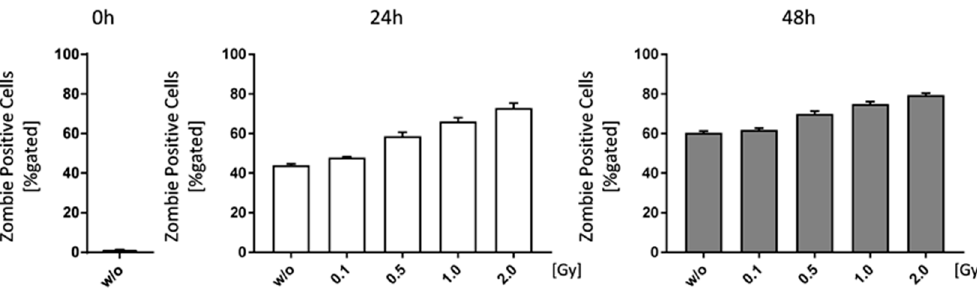
Figure 5. Low doses of ionizing radiation marginally increase cell death rates of bone-marrow. Bone-marrow cells were isolated from the long bones of male C57Bl/6 mice. For analyses 1 × 10 6 cells were seeded in duplicates and analyzed at different time points (0, 24 and 48 h). In order to distinguish live from dead cells a zombie dye (BioLegend) and multicolor flow cytometry have been used. Zombie negative cells have been considered live, whereas zombie positive cells were counted as dead. Depicted is joint data from one experiment with three 6 weeks old male mice whose bone-marrow has been analyzed independently and in duplicates. Data is presented as mean ± SEM and analysed by two-tailed Mann-Whitney-U test in comparison to untreated controls.